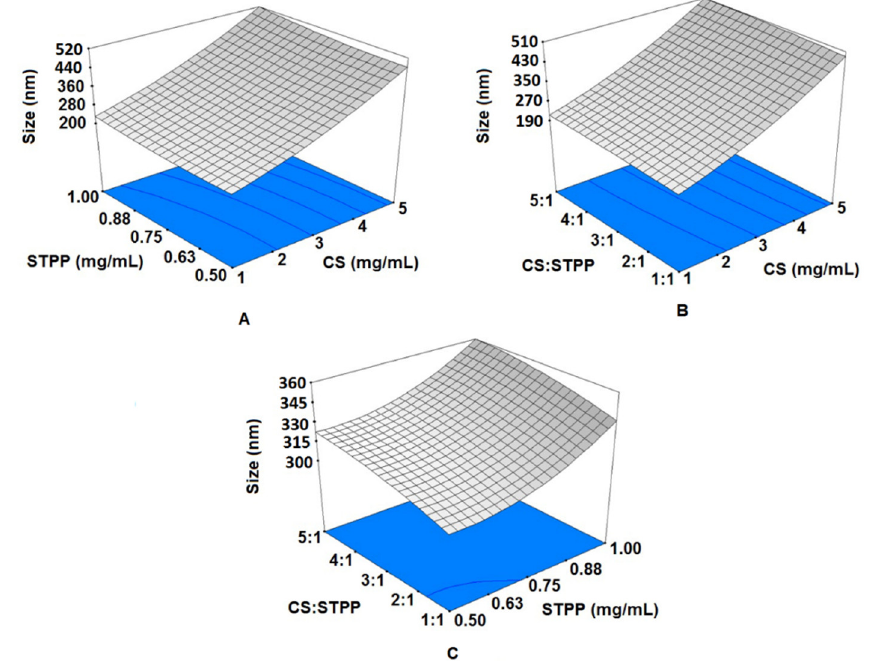
Figure 1. The influence of ( A ) chitosan (CS) and sodium tripolyphosphate (STPP) levels, ( B ) CS levels and the ratio of CS:STPP, and ( C ) STPP levels and the ratio of CS:STPP on the size of produced CS nanoparticles (CSNPs).